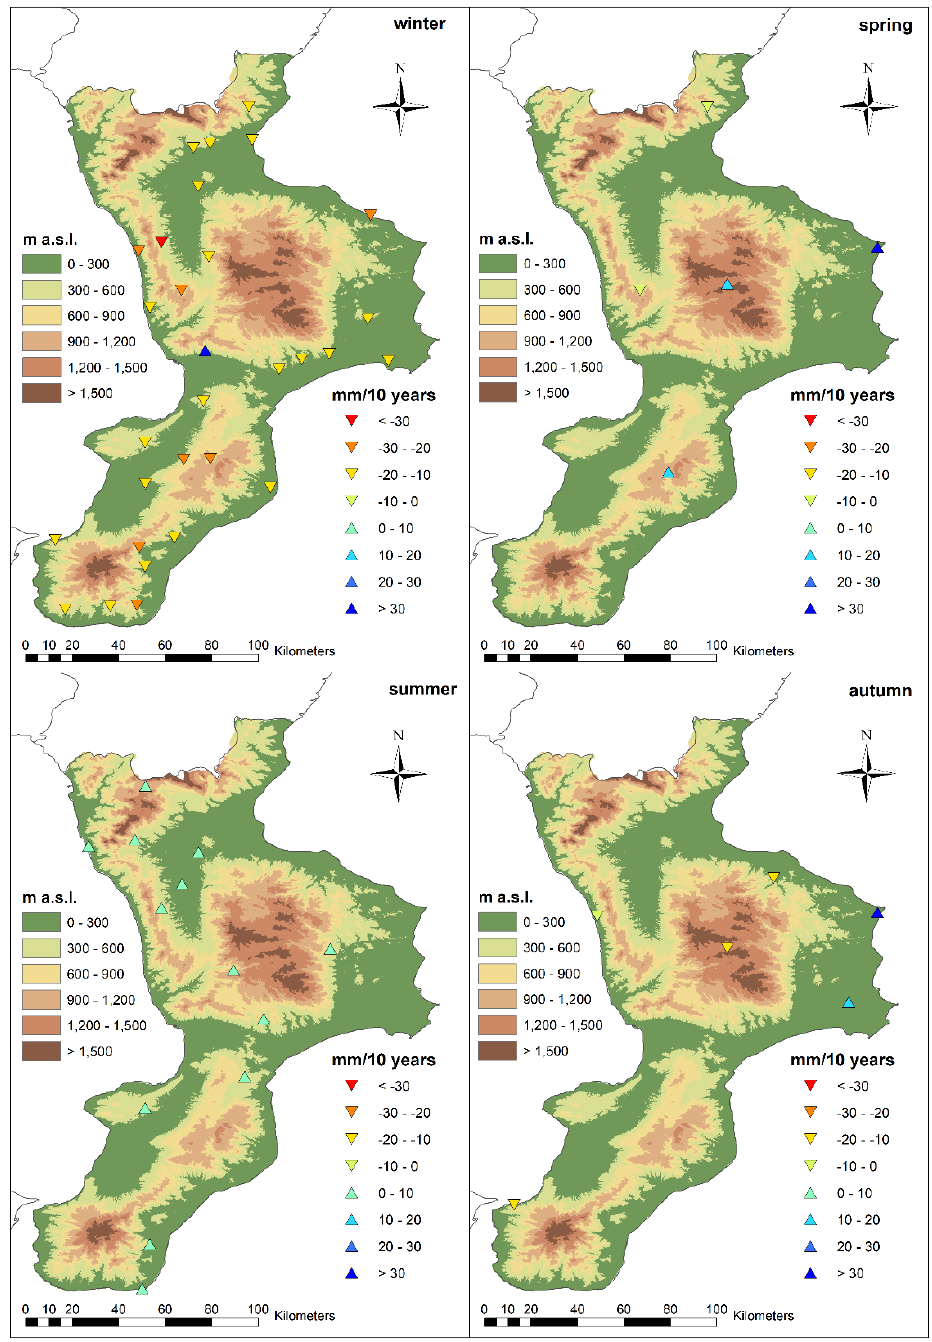
Figure 3. Spatial distribution of the rain gauges showing positive or negative seasonal rainfall